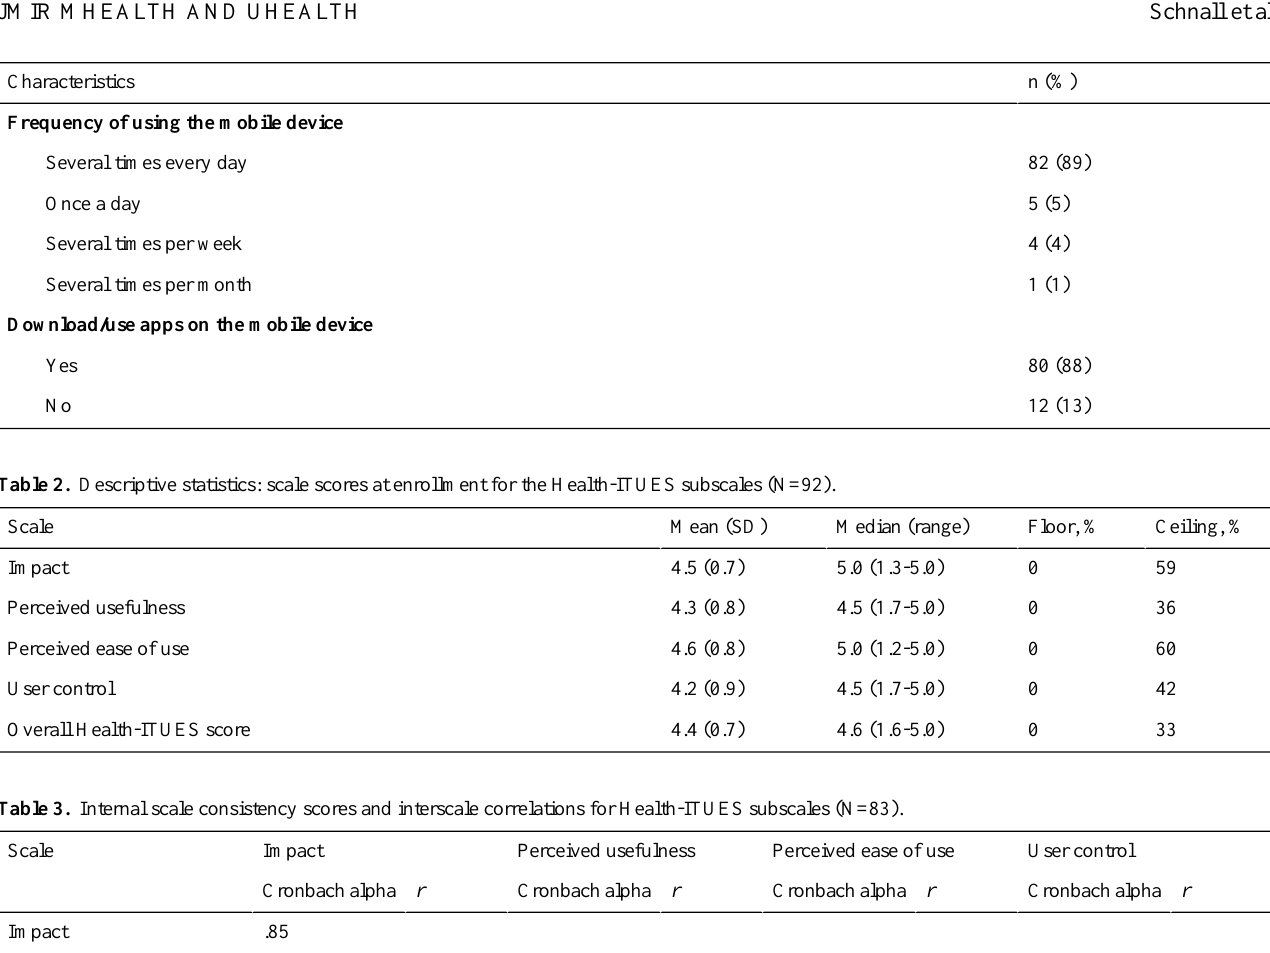
r Cronbach alpha r Cronbach alpha